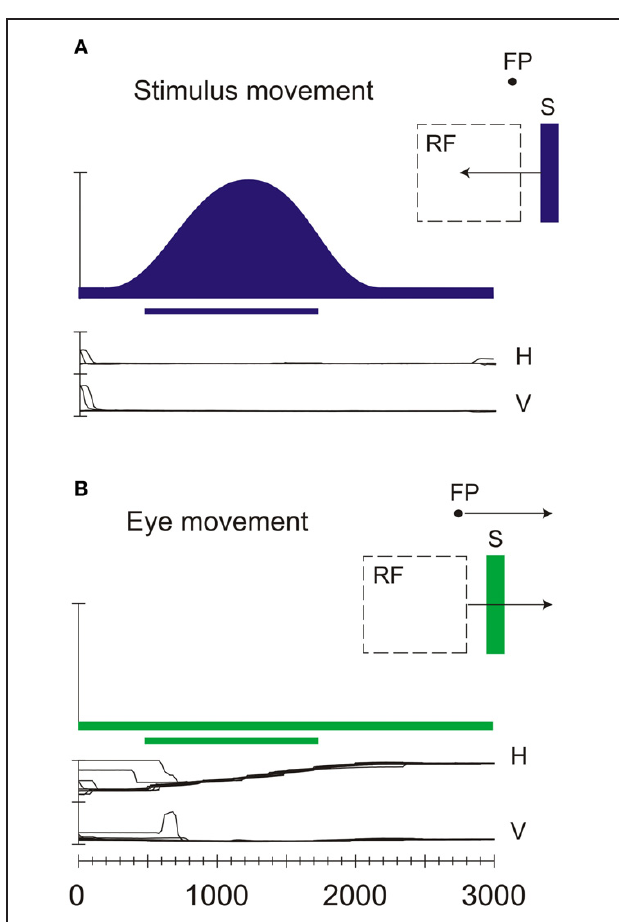
FIGURE 4 | Neural discharges of a real-motion cell recorded in area V6. (A) Neural responses evoked by sweeping an optimal visual stimulus (S) across the receptive field (RF) while the animal looked at a stationary fixation point (FP). H and V indicate the horizontal and vertical components, respectively, of the eye movements. (B) Neural activity evoked by sweeping the receptive field across the stationary visual stimulus thanks to the pursuit eye movement evoked by the movement of the fixation spot. All conventions are as in Figure 2B . Modified from Galletti and Fattori